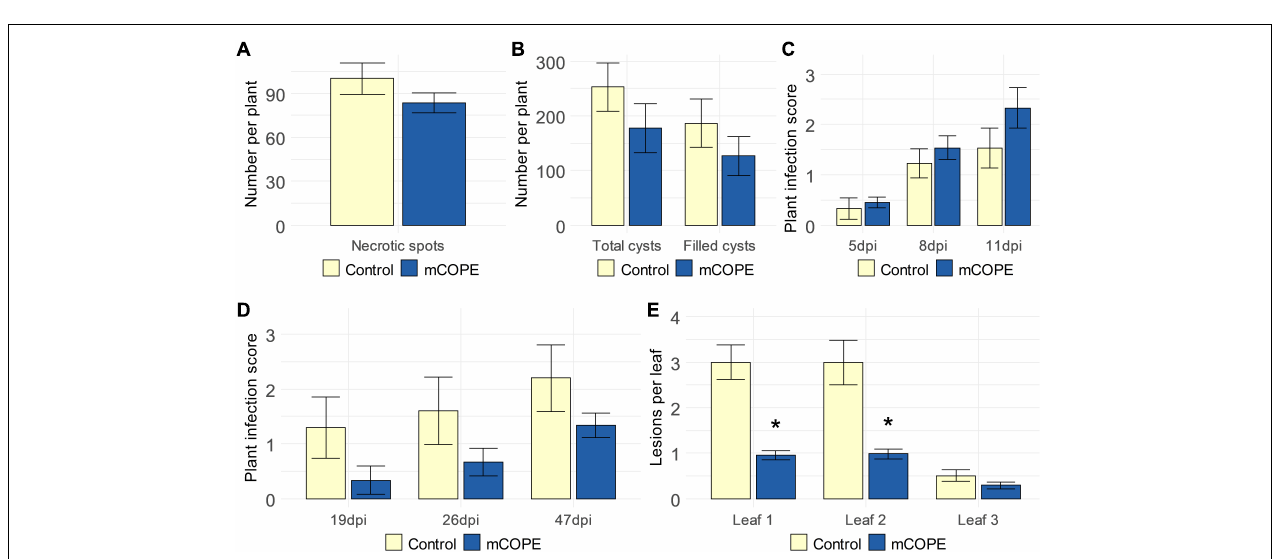
FIGURE 7 | Cucurbitaceae COld Peeling Extract (CCOPE) derived from melon ( Cucumis melo var. cantalupensis ; mCOPE) may predominantly lead to effective protection against biotrophs. (A) Number of necrotic spots observed in rice roots, 25 days post inoculation with 250 Pratylenchus zeae second-stage juveniles (J2s). (B) Total number of cysts and egg-filled cysts found in the soil surrounding sugar beets ( Beta vulgaris cv. Amarok), 6 weeks post inoculation with 300 Heterodera schachtii J2s. (C) Infection scores as assessed 5, 8, and 11 days post inoculation of strawberry ( Fragaria × ananassa ) with Botrytis cinerea (5, 8, and 11 dpi, respectively). (D) Infection scores as assessed nineteen, 26 and 47 days post inoculation of fodder beet ( B. vulgaris cv. Brunium) with Rhizoctonia solani (19, 26, and 47 dpi, respectively). (E) Number of lesions in the first, second, and third leaf of tomato plants, 4 days post inoculation with Pseudomonas syringae . (A–C,E) One day before inoculation, plant shoots were treated with mCOPE. (D) mCOPE treatment was done at the moment of sugar beet transfer into R. solani -inoculated sand. (A–E) Error bars represent the standard error of the mean. Asterisks indicate significant differences upon comparison of mCOPE-treated plants with same-aged control plants that were treated with the buffer. Statistical differences were determined via a two-sided heteroscedastic t -test ( p < 0.05). Asterisks indicate statistically significant differences upon comparison of CCOPE- and mock-treated cells.